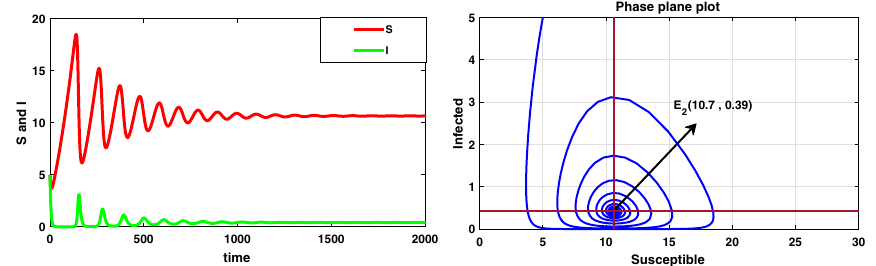
Fig. 4 A dynamic behaviour of system (3) with r > µ and the corresponding two-dimensional phase portrait of S,I with susceptible and infected isocline about endemic equilibrium point E 2